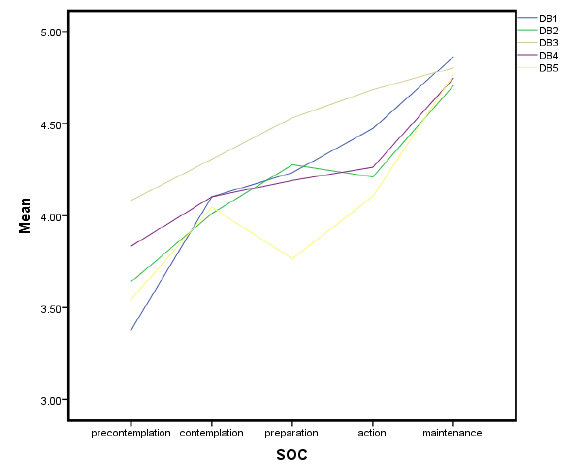
Figure 3. Comparing the score of negative affect situations (5 th to 8 th questions of self-efficacy scale) across stages of change.